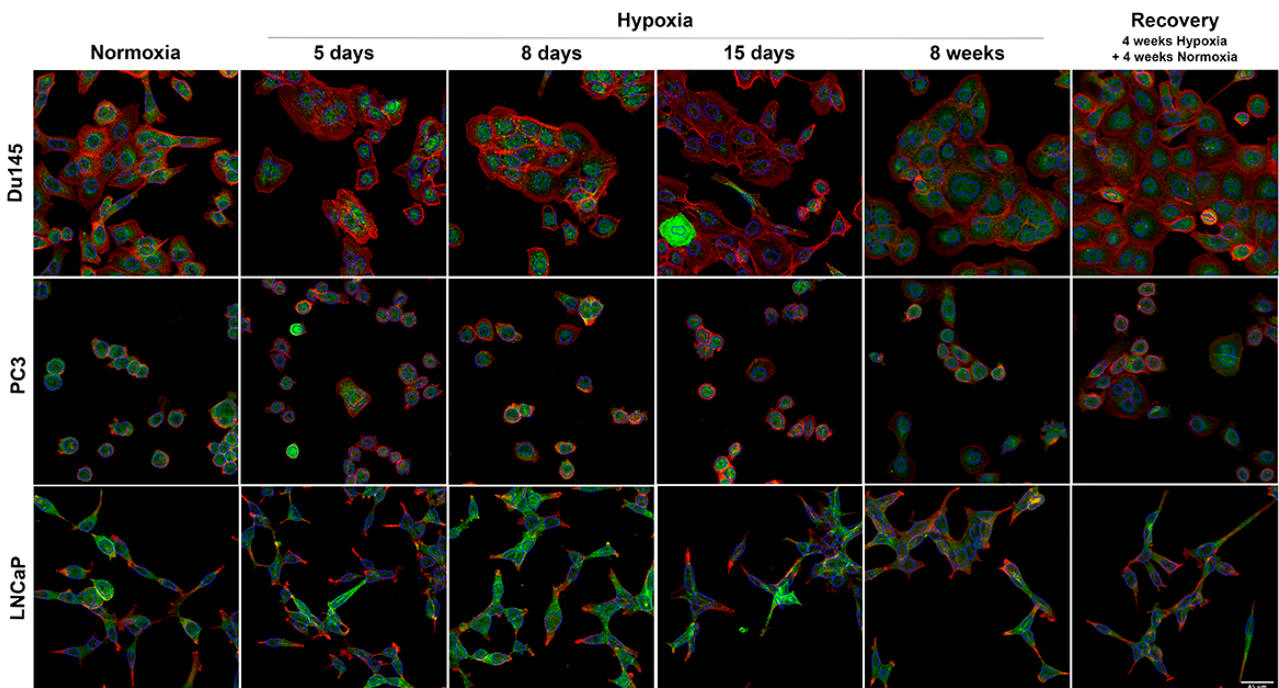
Figure 4. Maximum projection of Z-stack confocal microscopy images of Du145, PC3 and LNCaP cells under normoxia, acute hypoxia (days 5, 8 and 15), chronic hypoxia (8 weeks) and recovery (4 weeks hypoxia + 4 weeks normoxia). AQP3 is shown in green, while actin staining is shown in red. Nucleus is shown as a blue outline to allow clear observation of the green staining inside the nuclear area. Scale bar represents 45 µm.